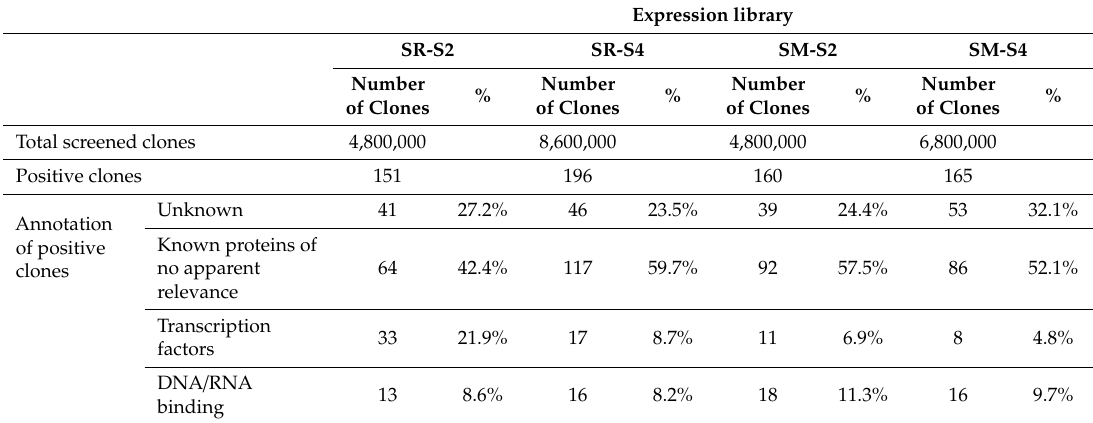
Table 1. Summary of clones isolated by the Yeast one-hybrid screen using the pPsACS1 bait strain. Expression library